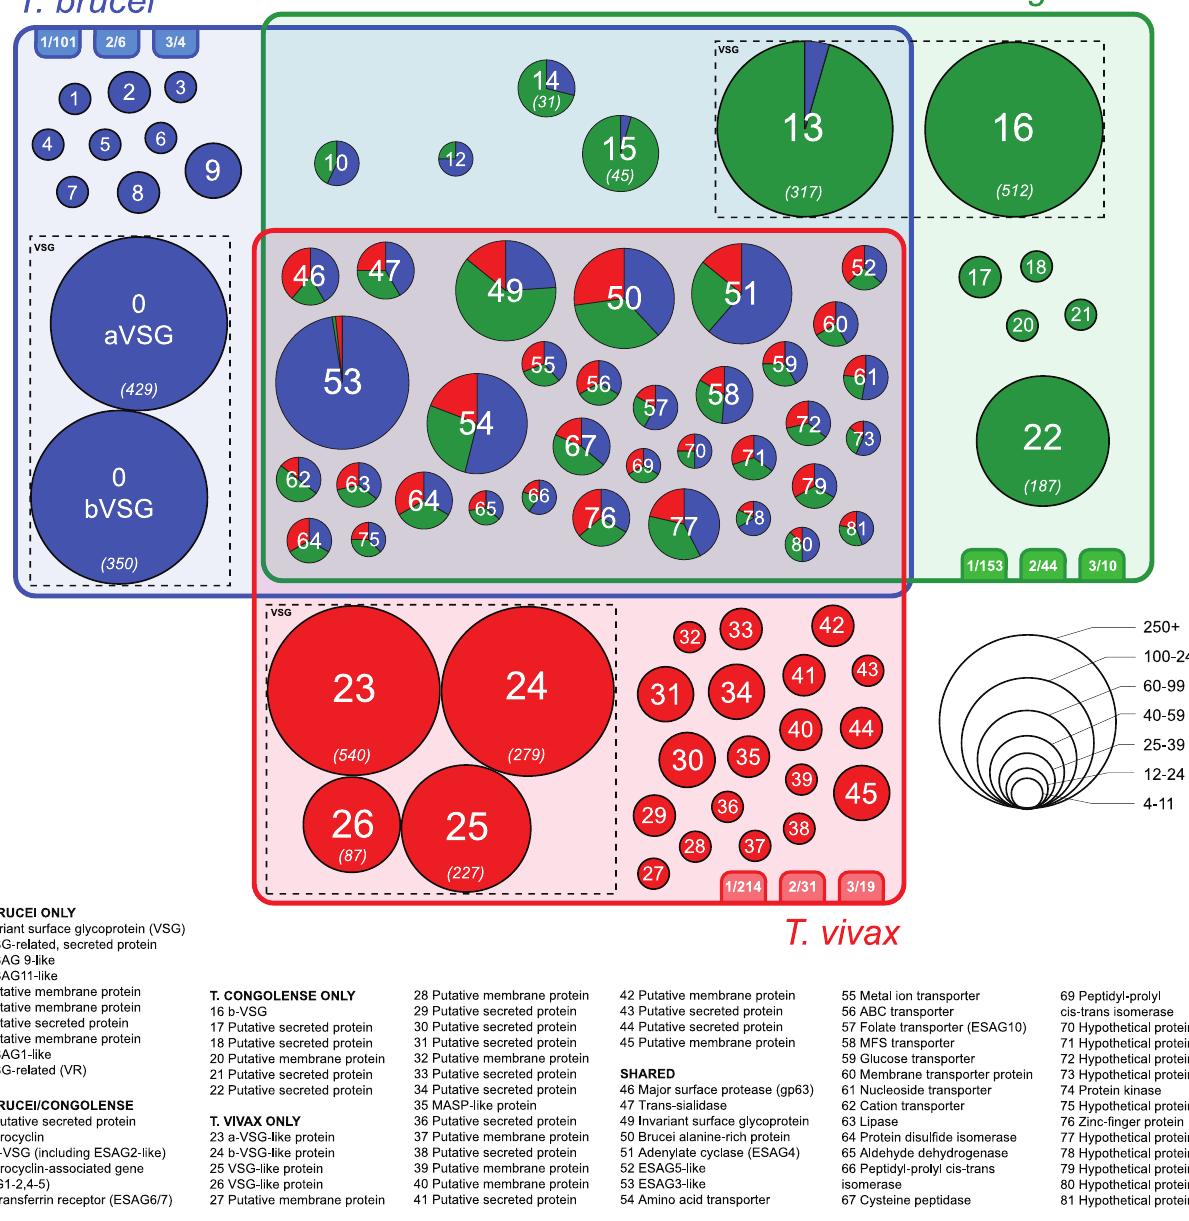
consist of species-specific clades of highly similar, tandem duplicates, at one or a few conserved loci. Fam47 ( trans -sialidase; r = 0.025) and Fam51 (adenylate cyclase; r = 0.002) provide examples intermediate between the first and second patterns, with T. brucei and T. congolense possessing orthologs to conserved loci, while all T. vivax genes are monophyletic and hence lack orthology with other species.